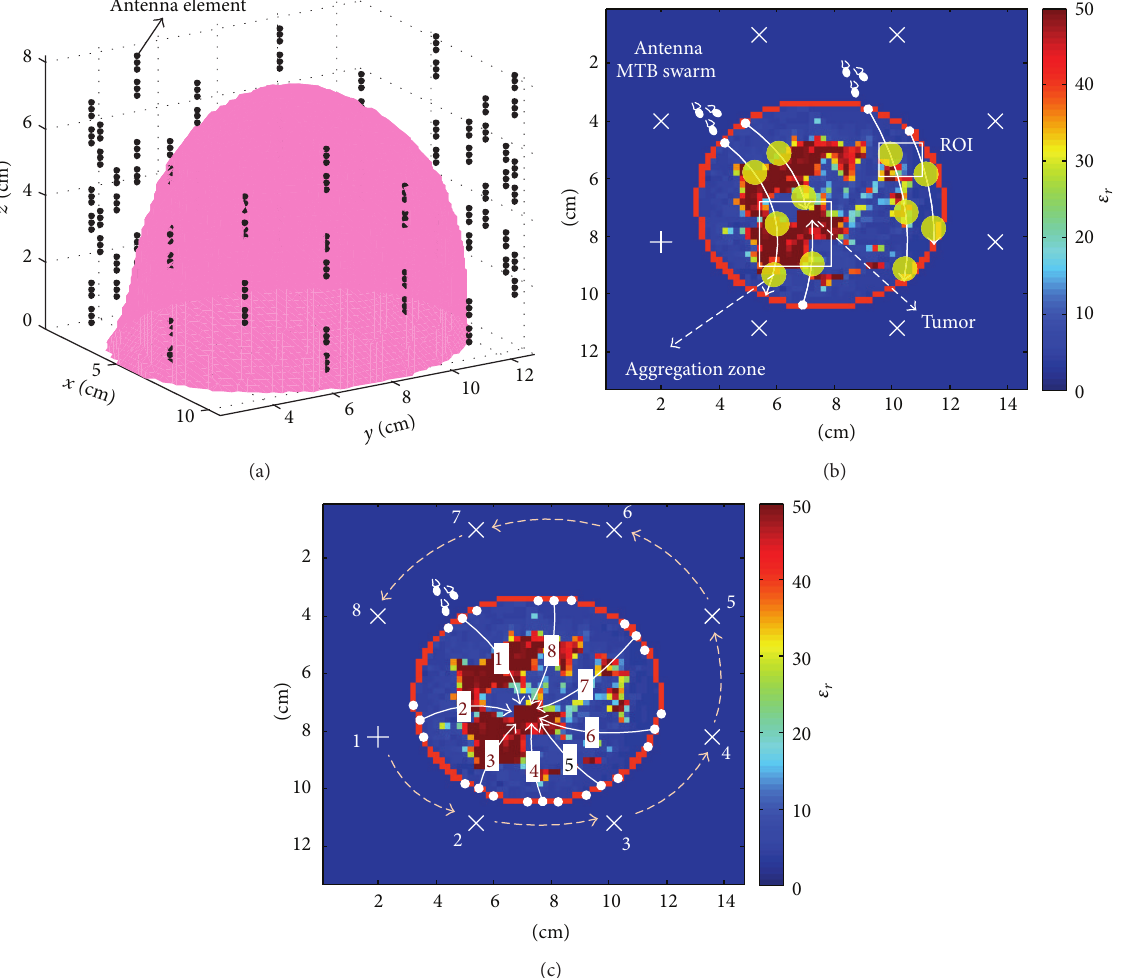
Figure 3: (a) Illustration of the tumor sensing and diagnosis system using a configuration similar to [8, 11]. (b) Dielectric profile at 1 GHz for the coronal cross-section through the third antenna ring. We assume concentric magnetic field lines originating from a dc source via one of the antennas (marked with a “+”) during the propulsion-and-steering phase. All the eight antennas probe the breast sequentially with UWB pulses during the tracking phase after the MTB reach the targeted aggregation zones (marked with yellow circles). Two clumps of MTB are injected simultaneously into the breast. (c) Size estimation of the tumor by targeting it from different angles; the eight antennas are sequentially employed to carry a dc for generation of magnetic